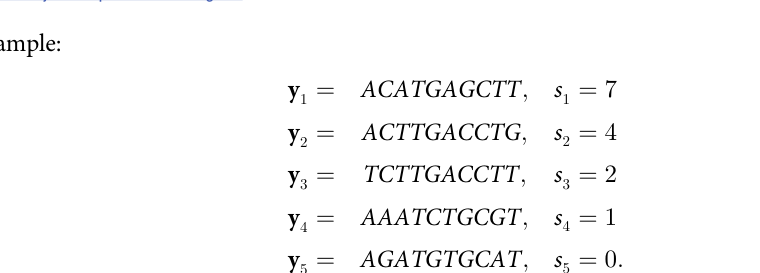
Fig 1. Illustration of an example heterochronous genealogy with n = 5 lineages. Sampling times s 1 , ... , s 5 and coalescent times t 1 , ... , t 5 are marked below the genealogy, and sequence data y 1 , ... , y 5 are marked at their corresponding tips.